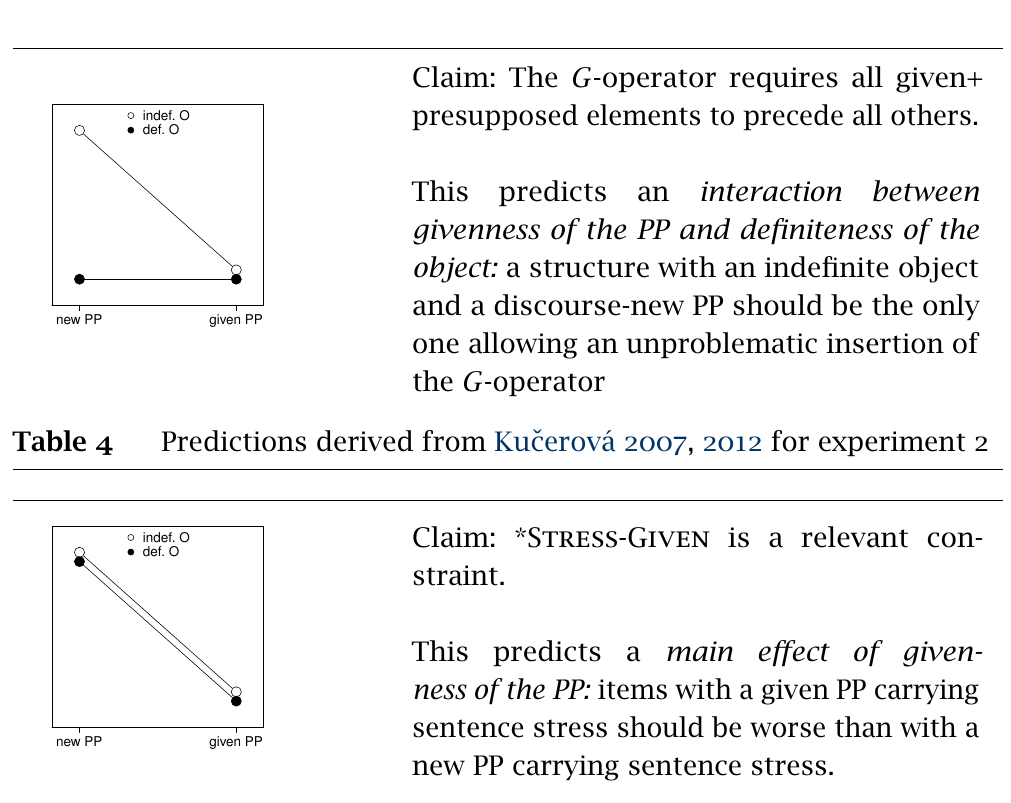
Predictions of the prosodic approach for experiment